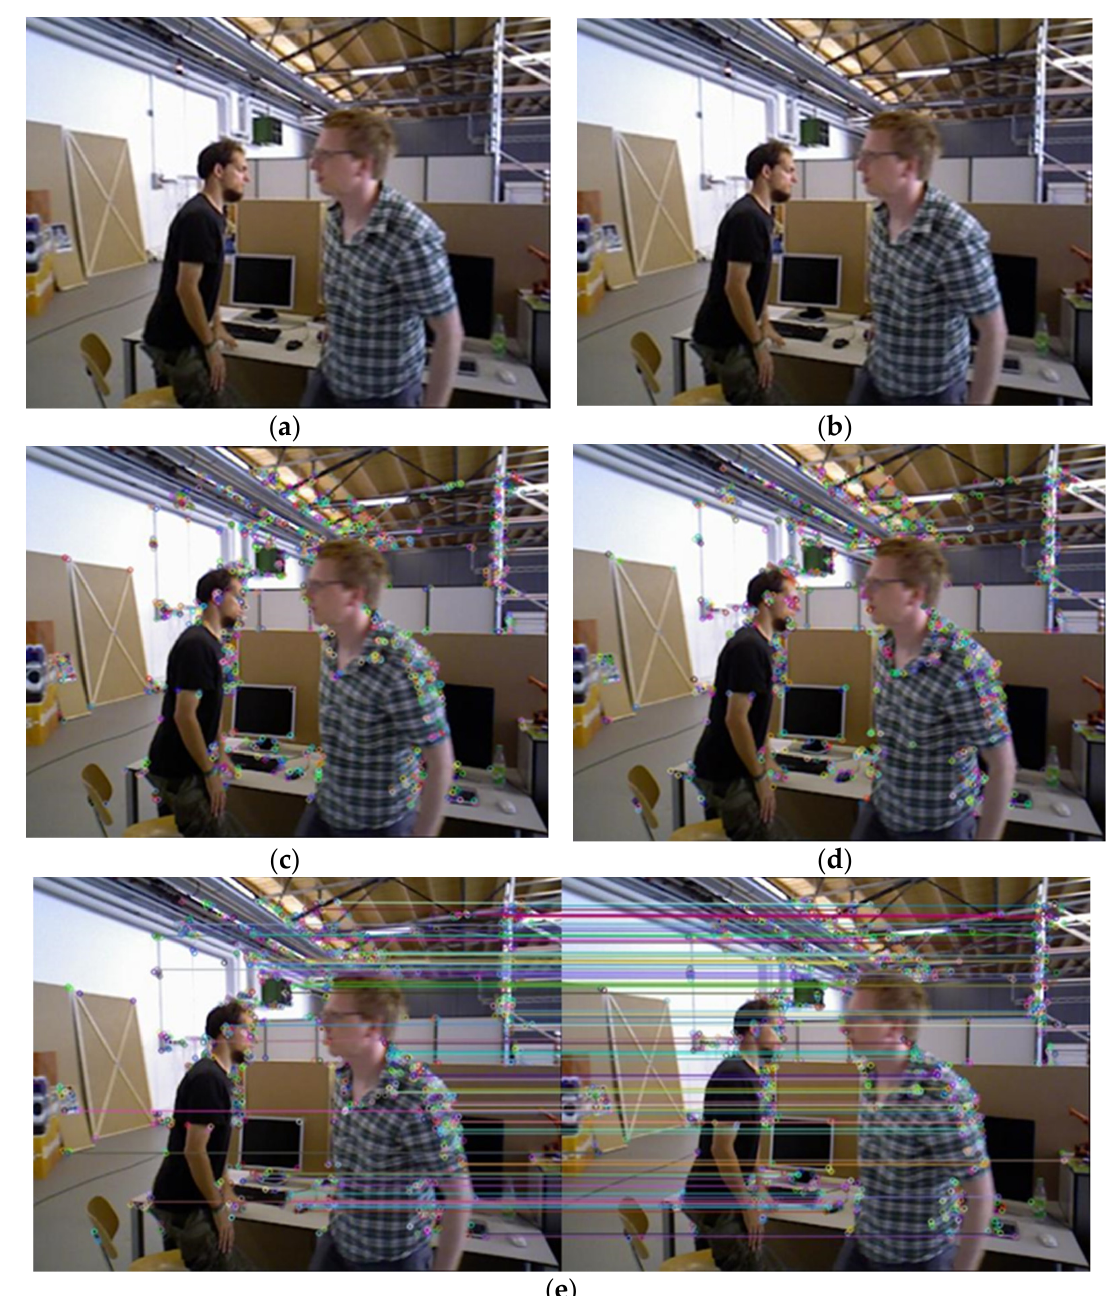
Figure 9. Results of feature extraction and matching based on ORB-SLAM2: ( a ) Original Figure 1; ( b ) Original Figure 2; ( c ) Feature points extracted before screening of original Figure 1; ( d ) Feature points extracted before screening of original Figure 2; ( e ) The ORB matching results of original Figures 1 and 2.